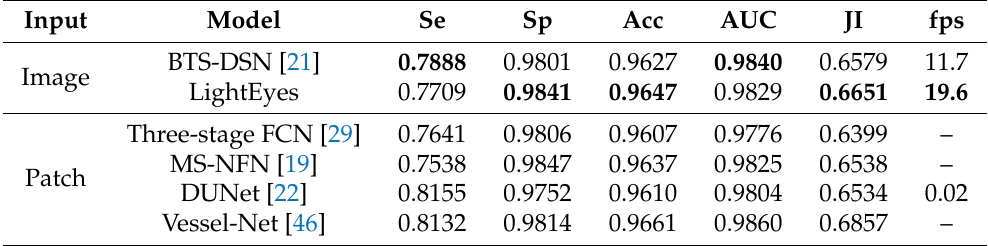
Table 6. Segmentation results of vessel on the CHASE_DB1 dataset (best results shown in bold).